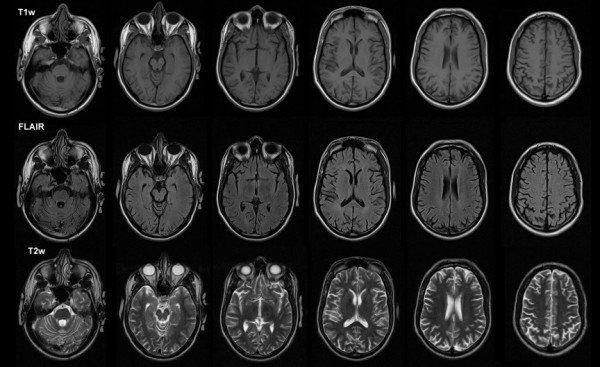
Representative axial slices from clinical MRI scans of the TBI patient. T1-weighted (top row), FLAIR (middle row) and T2-weighted images. The scans were interpreted as normal at the initial neuroradiological examination. Images are displayed according to radiological convention (right side of the brain is shown on the left side of figure).